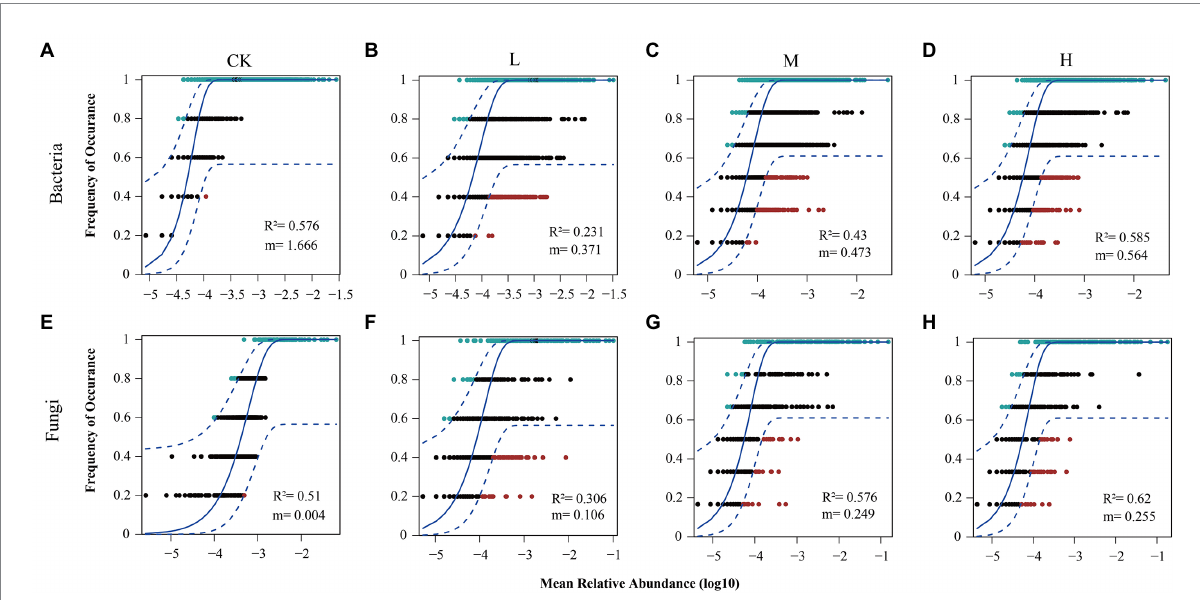
FIGURE 7 Fit of the NCM for community assembly. Bacterial community assembly at different RI levels (A–D) . Fungal community assembly at different RI levels (E–H) . The solid blue line indicates the best fit to Sloan’s neutral model. The dashed blue lines represent 95% confidence intervals around the model prediction. OTUs with frequencies higher and lower than the predicted occurrence frequency by NCM are shown in blue and red, respectively.